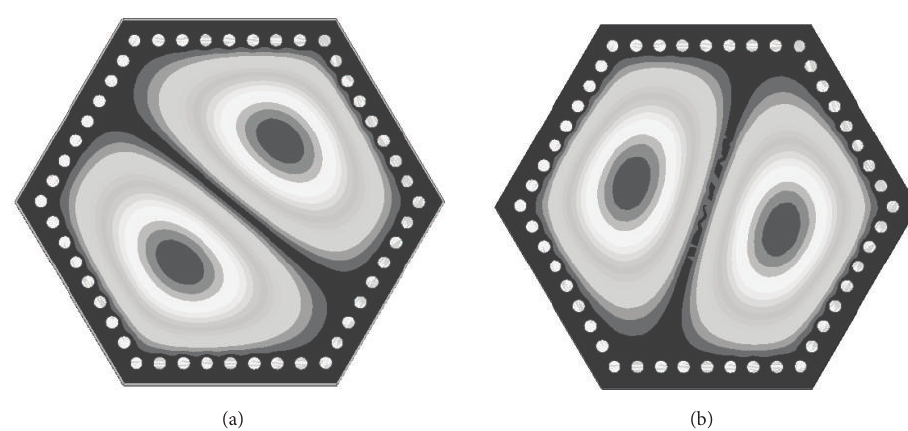
Figure 3: The E-field distributions of 𝑇𝑀 110 degenerated mode: (a) left inclined mode and (b) right inclined mode.